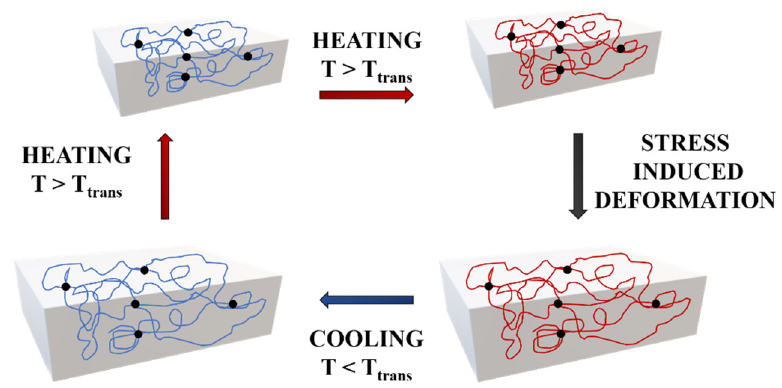
Figure 3. Mechanism of thermally induced shape-memory polymers.